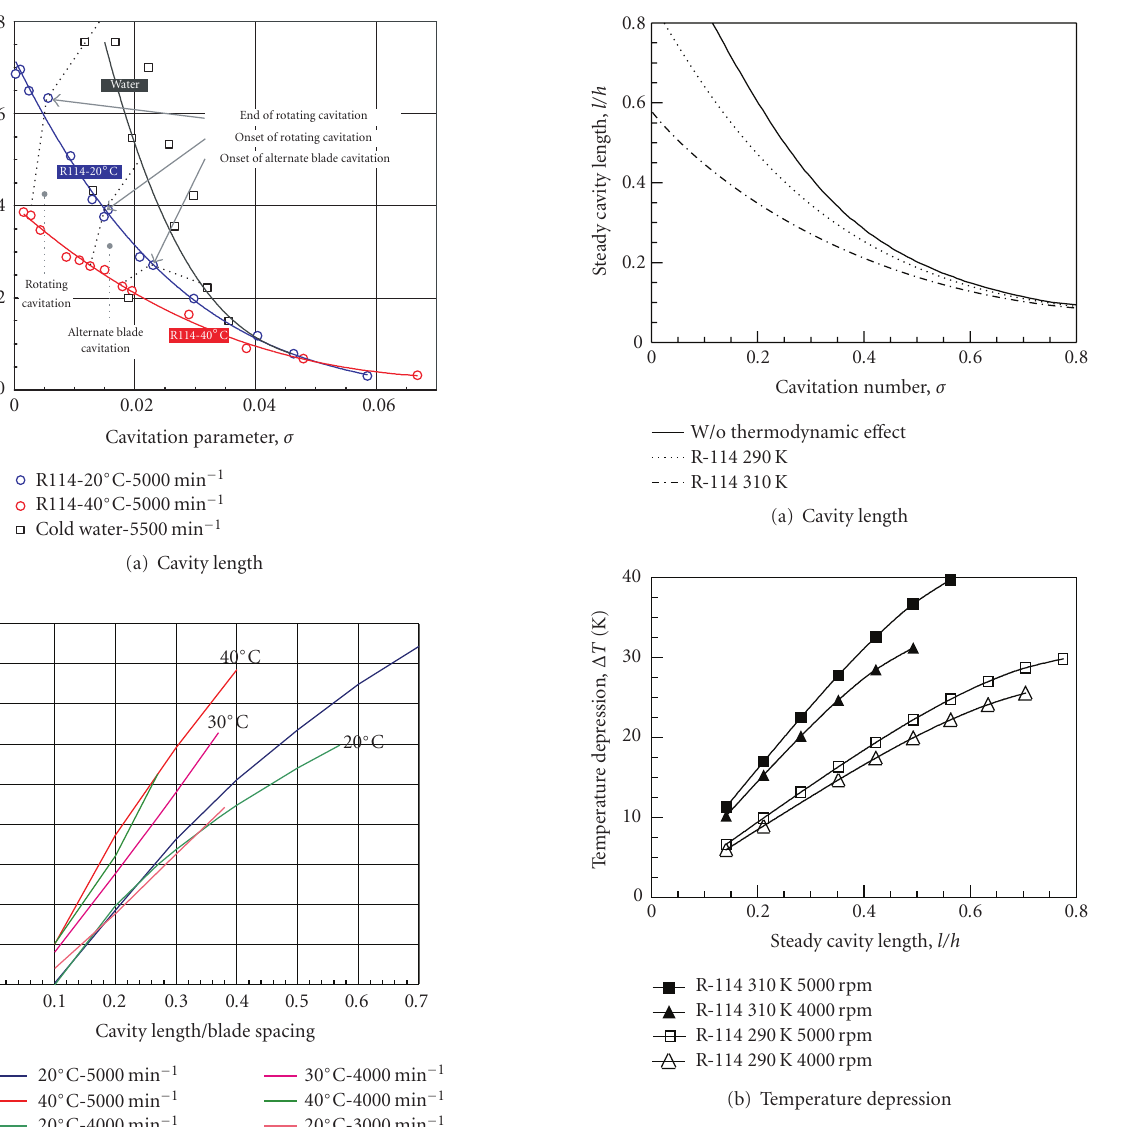
Figure 4: Numerical results in the case of R-114 and cold water. flow velocity are chosen as α = 4.32 ◦ and U = 34.0 m/s with the rotational speed of 5000 min − 1 . The turbulence di ff usion factor ε is unknown but is set to be 1000, which gives comparable figures with the experimental ones.